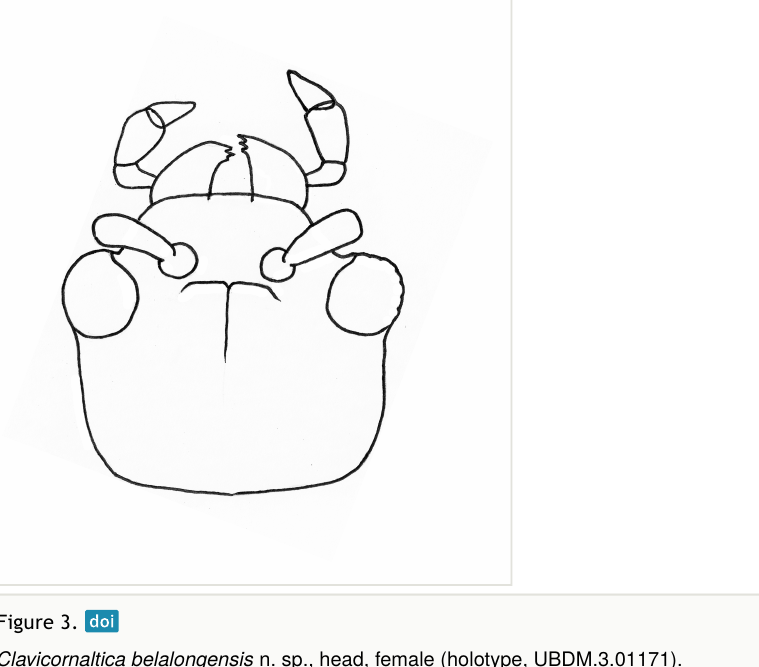
Clavicornaltica belalongensis n. sp., head, female (holotype,